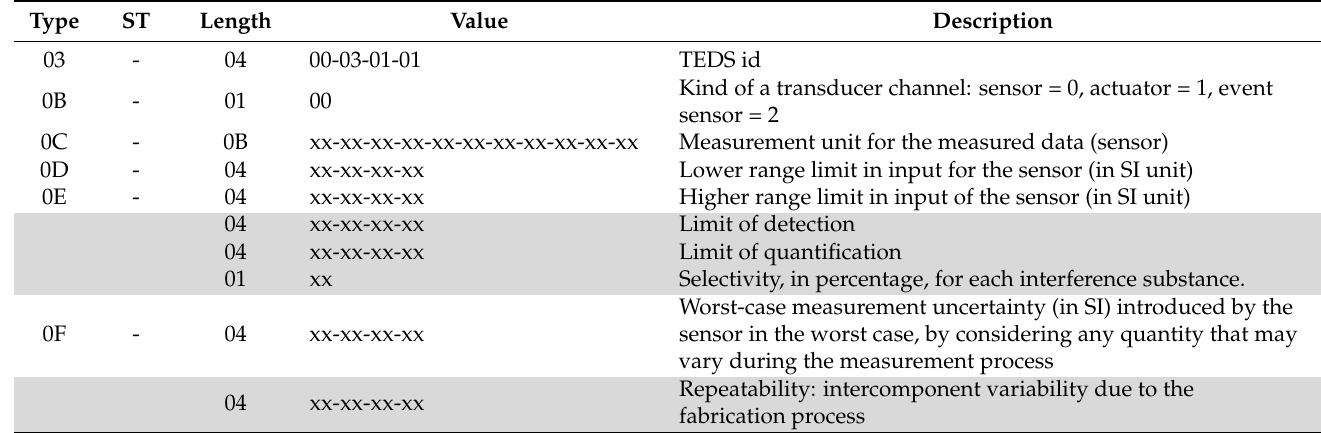
Table 6. Transducer channel TEDS structure for a generic sensor (white) integrated with information that should be provided for a biosensor